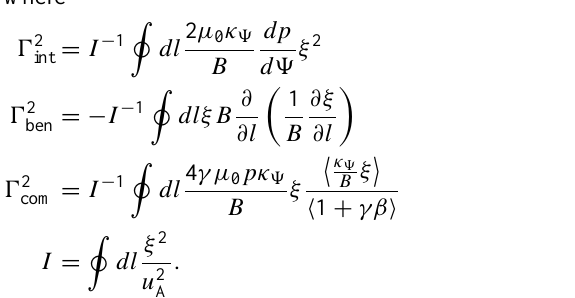
Fig. 4. Tailward flow (left column) and normal ( z -) component of the magnetic field (right column) profiles along line y = z = 0 at four time slices prior to the first aurora intensification. In both columns, the green dashed lines represent the zero horizontal axes.